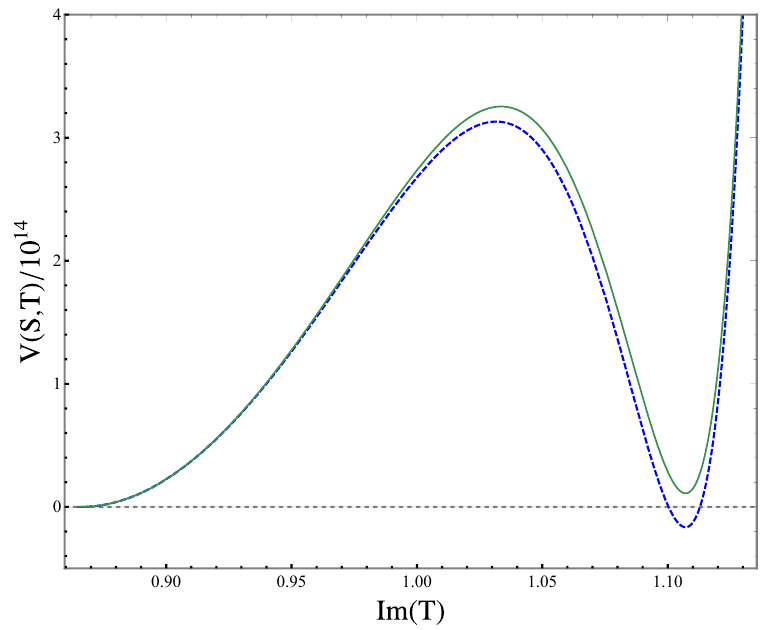
Figure 7 . Potential for the parameters { β = 10 − 3 , m = 2 , n = 2 } . The AdS global minimum is located at T = − 0 . 5+1 . 107 i while the fixed point T = ρ is a Minkowski local minimum as expected from section 3.2. When we turn the dilaton dependence on and A ( S, ¯ S ) satisfies eq. (3.18), the minimum in the outer rim becomes a dS local minimum, while T = ρ stays a Minkowski